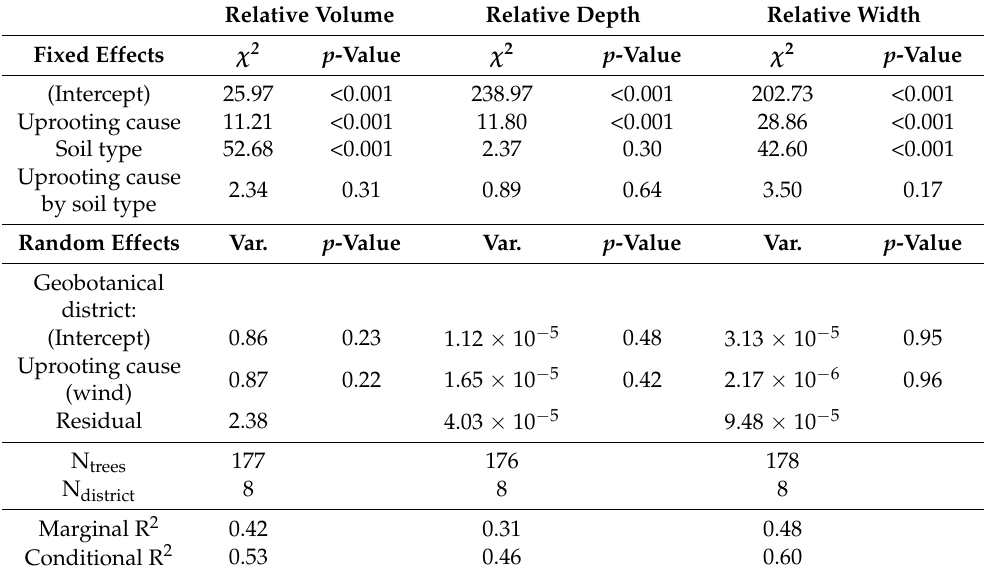
Table 1. Strength (Wald’s χ 2 ) and significance ( p -value) of the fixed effects of uprooting cause and soil type, as well as random variances and significance of the geobotanical district and model performance (R 2 ) for the volume (expressed per stemwood volume), depth, and width (expressed per stem diameter at breast height) of soil–root plate of Eastern Baltic silver birch on freely draining mineral, drained deep peat, and periodically waterlogged mineral